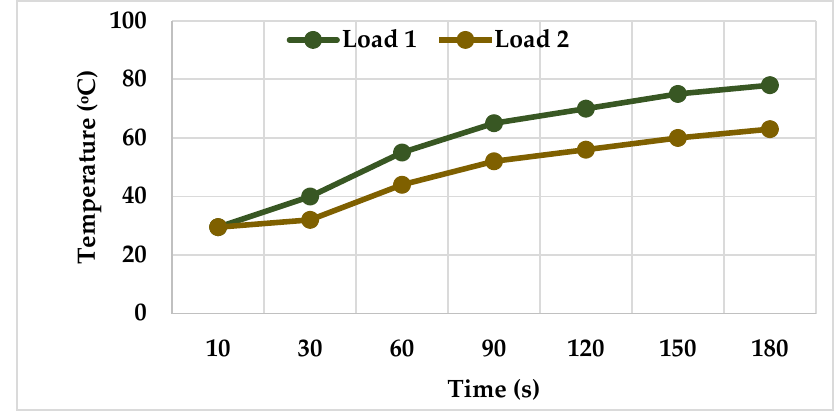
Figure 12. Variations of temperature with respect to time.